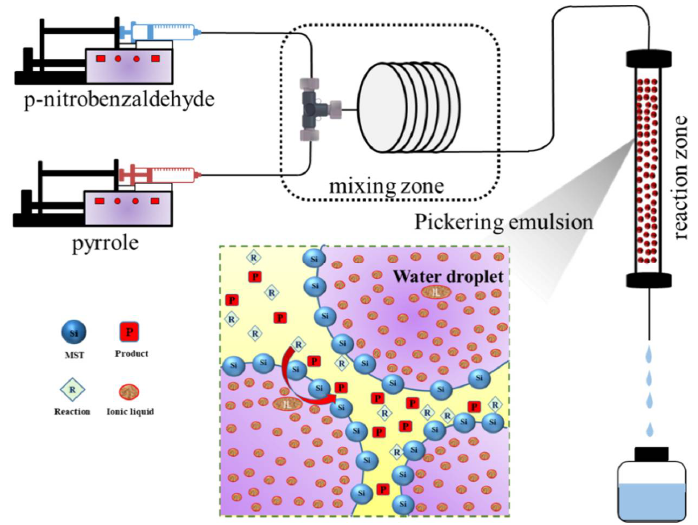
Figure 1. Schematic diagram for the continuous synthesis of 2,2′-(4-nitrophenyl) dipyrromethane in the Pickering-emulsion-based packed-bed microreactor.